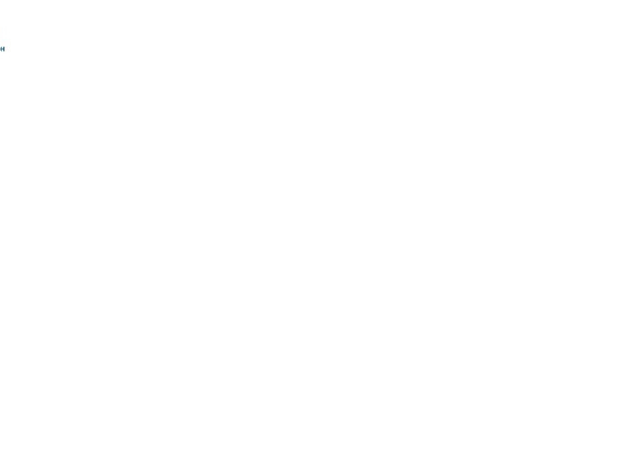
Figure 2. Possible primary signaling pathways (GPBAR1 and FXR) and the potential role of endogenous bile acids in models of neurodegenerative disorders. BA—bile acids, C—cholesterol, FXR — farnesoid X receptor, GPBAR1—G protein-coupled bile acid receptor 1.